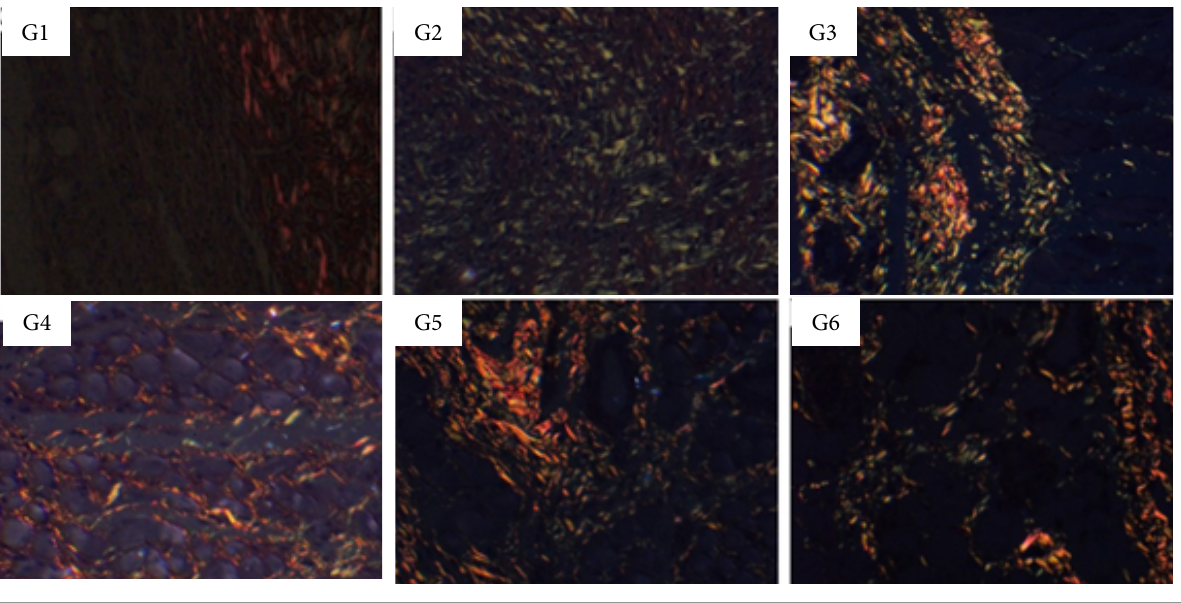
Figure 11 - Collagen fibers deposition in partial thickness burn wounds experimentally induced in Wistar rats 14 days after the injury induction (DAI). Collagen fibers type I are shown in red and type III in green. Stain Picrosirius red. Augmentation: 20x scale in μ